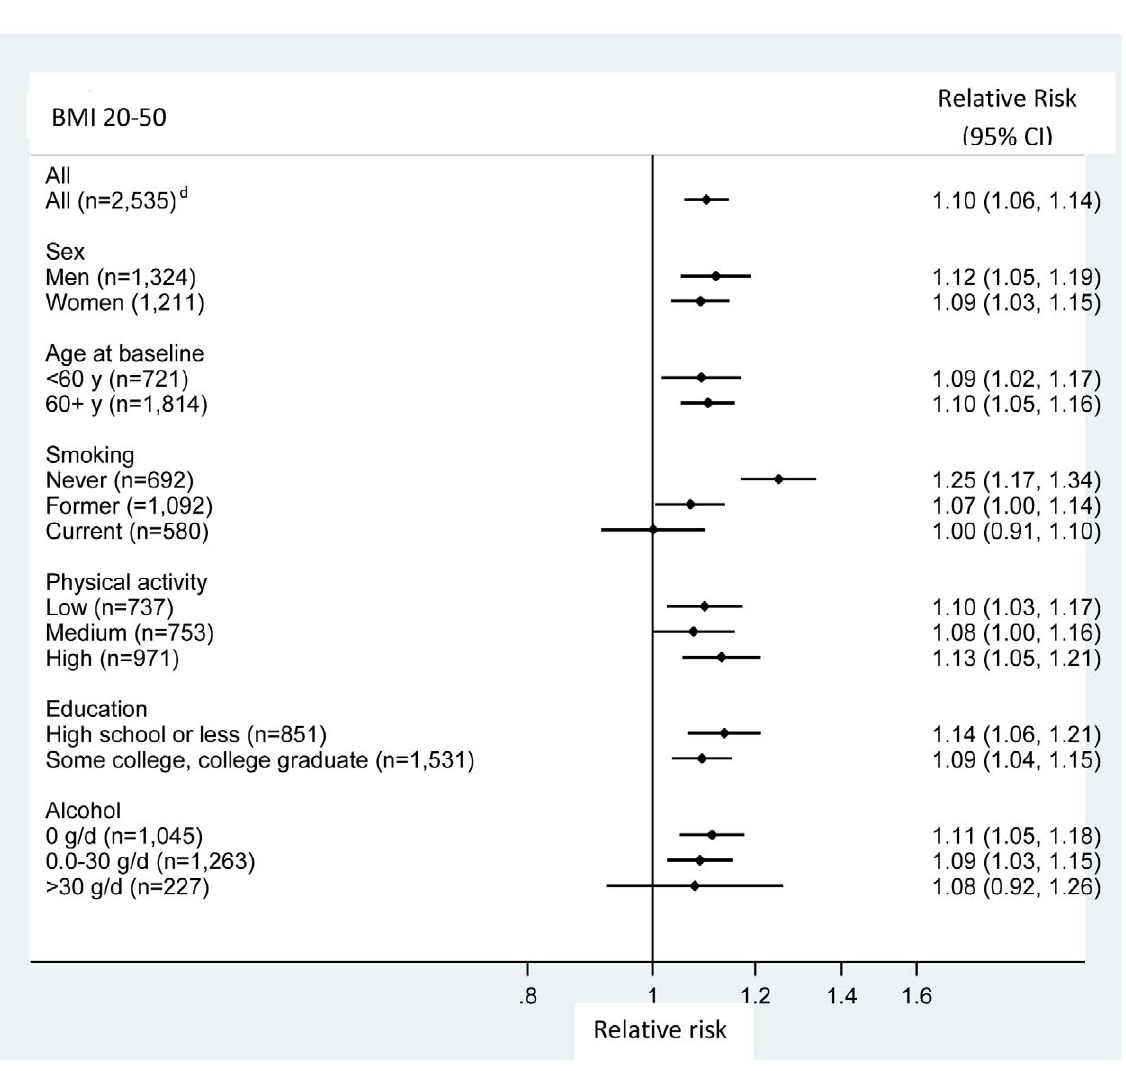
Figure 2. Relative risk for total mortality per 5-unit increase in body mass index in non-Hispanic blacks, according to selected characteristics a, b, c . a. Subjects who did not have any prevalent cancer except non-melanoma skin cancer or heart disease at baseline. b. Adjusted for following variables, except for the stratification variable in each analysis: age, sex, education, marital status, smoking status, time since quitting smoking, number of cigarettes per day, physical activity, alcohol consumption, and menopausal hormone therapy use in women. c. Markers indicate the relative risks and horizontal lines indicate 95% confidence intervals. d. Number of death; p value for interaction: 0.55 for sex, 0.50 for age at baseline, , 0.001 for smoking, 0.75 for physical activity, 0.40 for education, and 0.13 for alcohol.